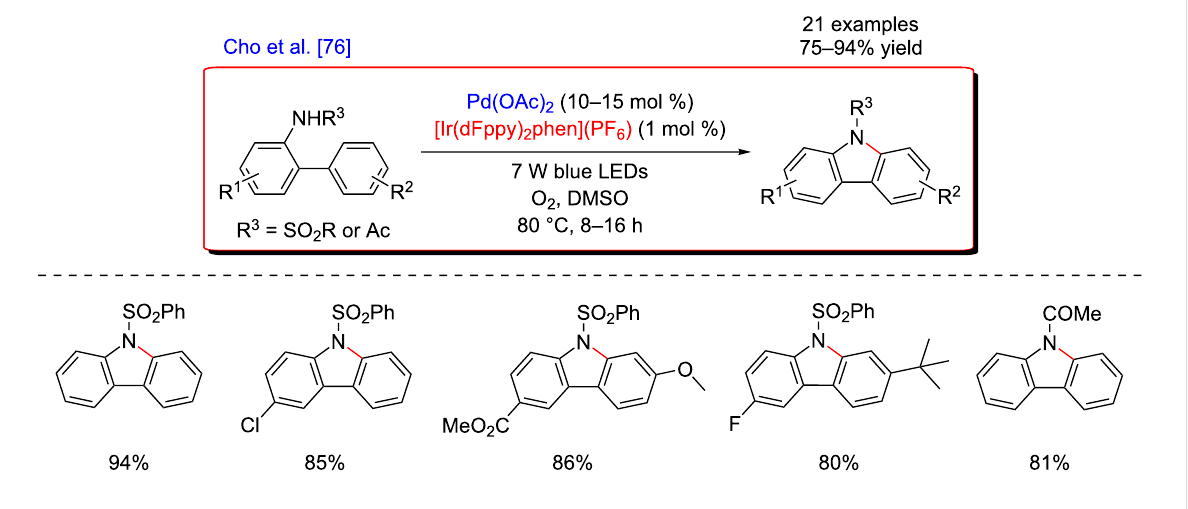
In 2015, Cho’s group became interested in implementing such mild and sustainable reoxidation protocol in a Pd-catalyzed C–H activation reaction, focusing mainly on an intramolecular direct C–N coupling. Thus, an efficient method for the synthe- sis of carbazoles via an intramolecular C–H amination was de- veloped, using N -substituted 2-aminobiaryl derivatives as the